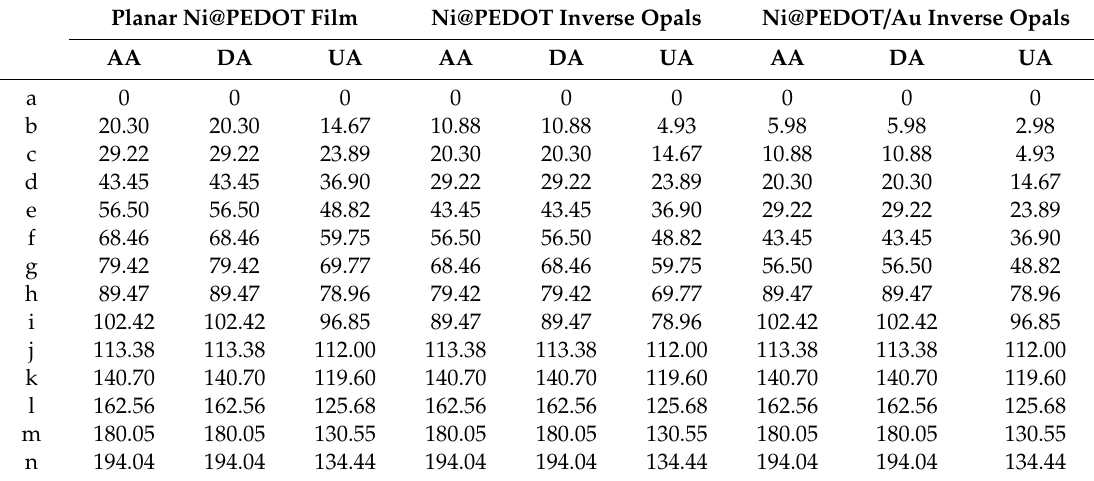
Table 3. The compositions of PBS containing various concentrations of AA, DA, and UA for CV scans displayed in Figure 9. The electrolyte is 0.1 M PBS containing various concentrations of AA (0–194 µ M), DA (0–194 µ M), and UA (0–134.4 µ M).